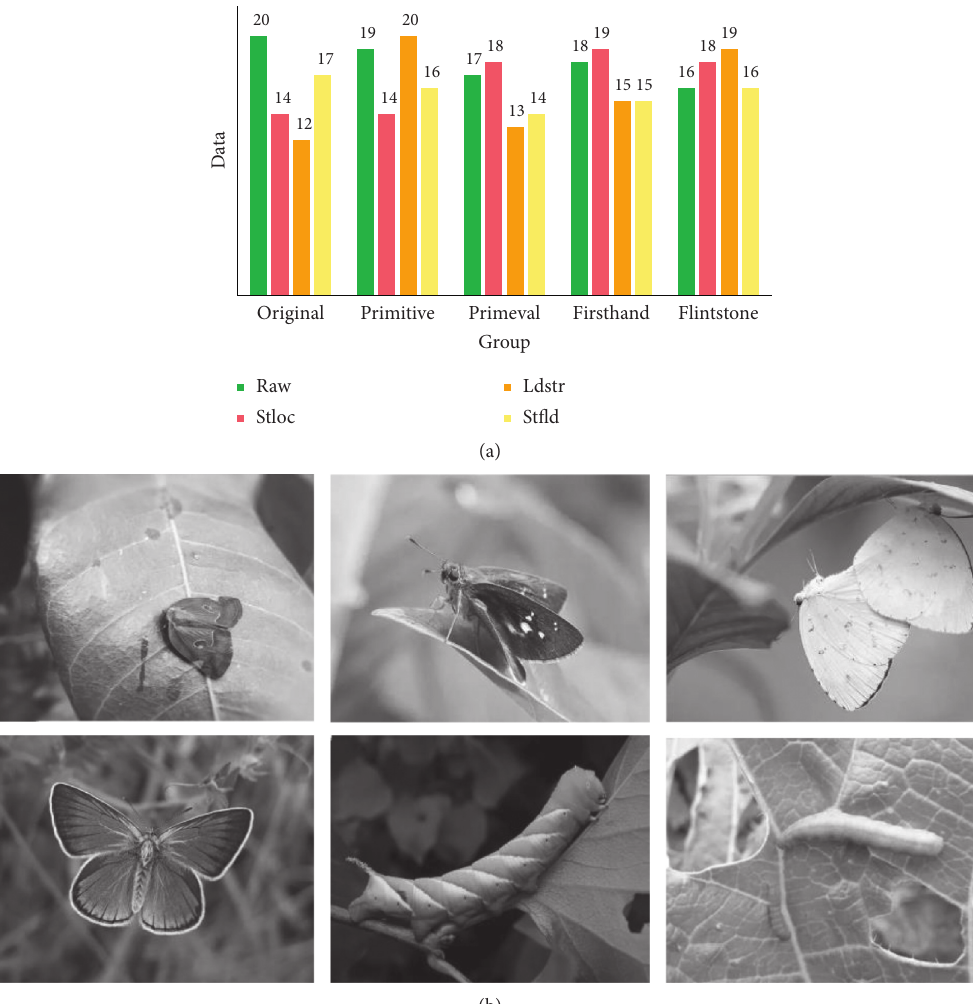
Figure 4: The acquisition of the original image of the leaf-curler moth. (a) The acquisition of the original image of the leaf-curler moth. (b) Six categories of